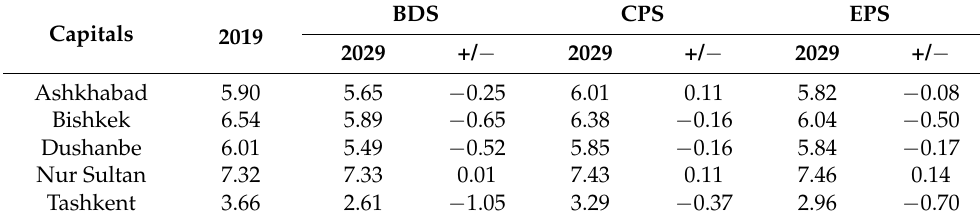
Figure 3. Simulation for urban land use under three scenarios in 2029. Table 3. Carbon storage changes under three scenarios